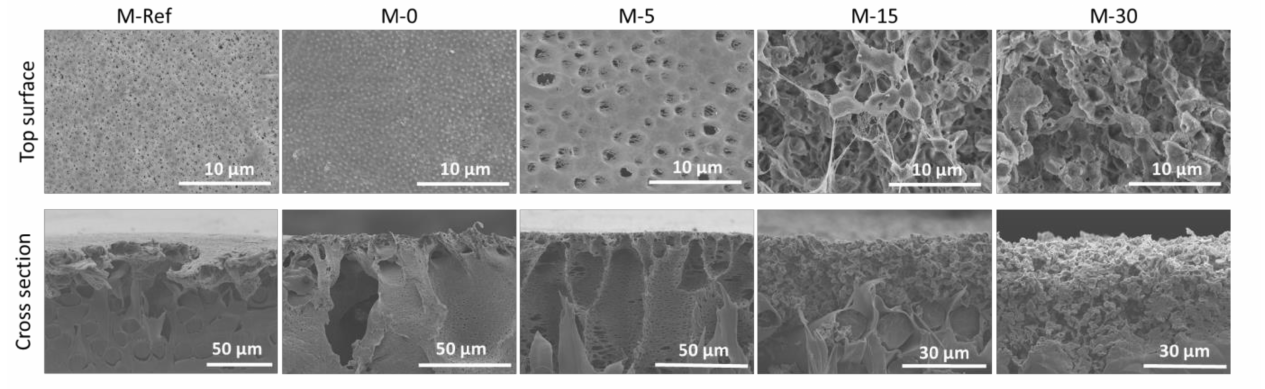
Figure 3. Surface and cross-sectional morphology of the